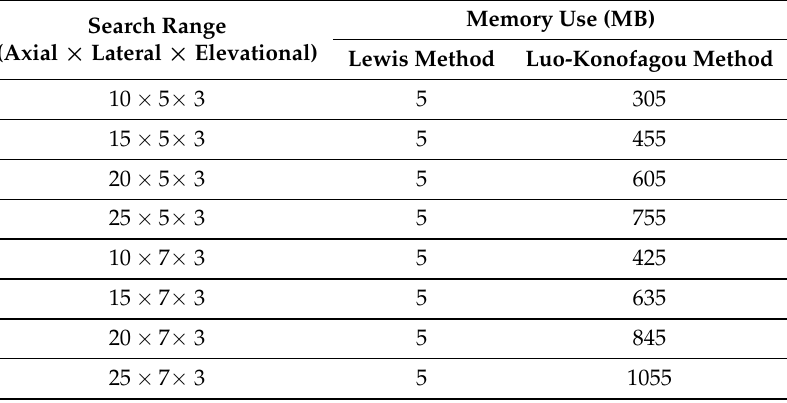
Table A3. A Summary of memory usage for Setting up Sum-tables needed for Lewis’ and Luo-Konofagou